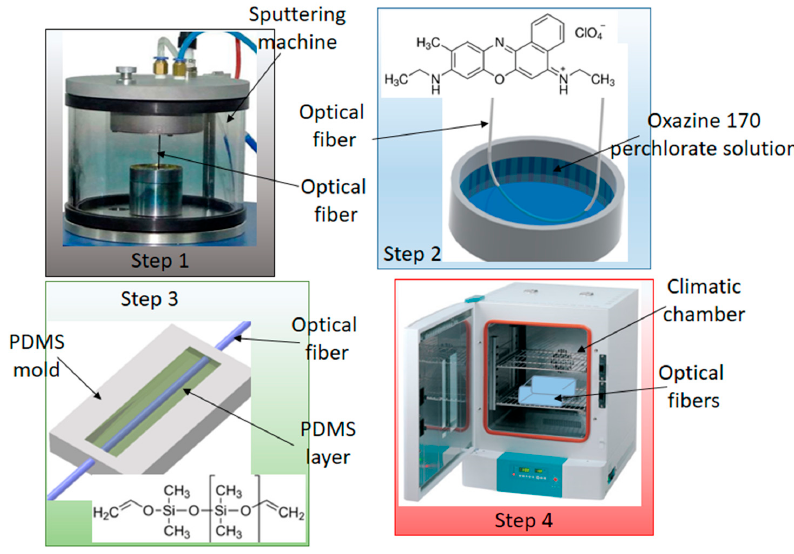
Figure 1. Schematic representation of the steps for the samples preparation.